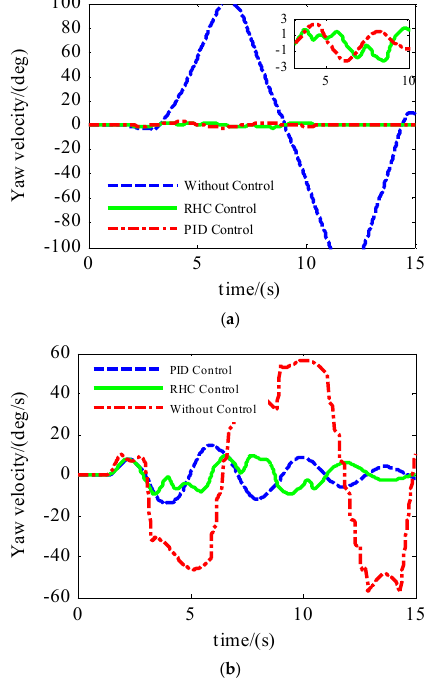
Figure 4. ( a ) Sideslip angle; ( b ) Yaw rate.